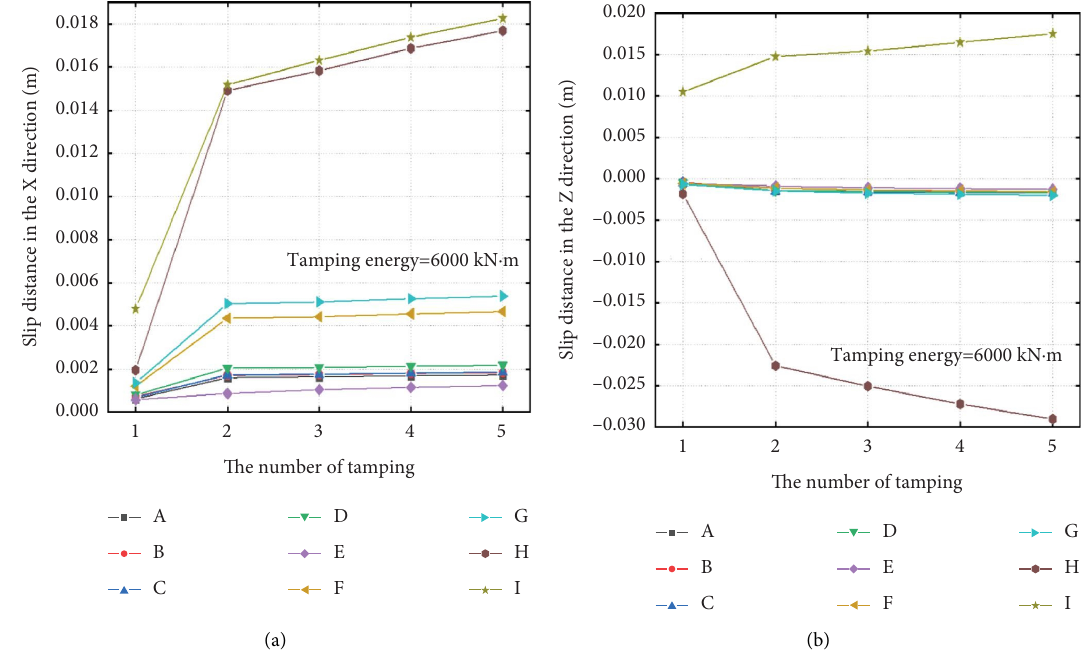
Figure 12: Horizontal and vertical displacements of soil at diferent positions under the action of 6000kN · m. (a) Horizontal displacement and (b) vertical vertical height of point F was 48.75 m. Te horizontal sliding distances of other points were shown in Figure 13(a). Terefore, when the ramming energy acting on the slope was